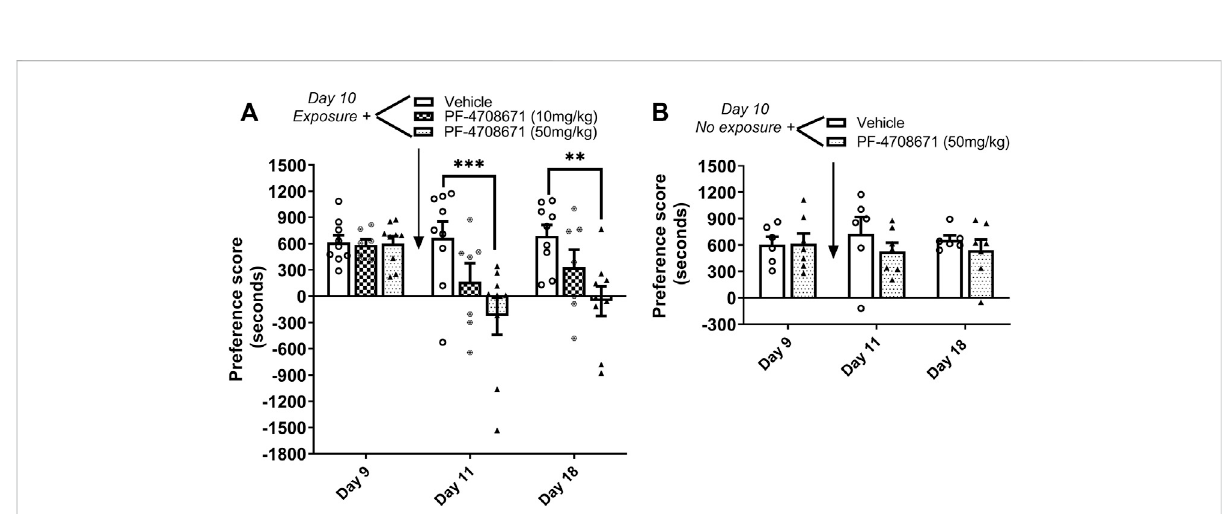
FIGURE 4 Inhibition of p70S6K attenuates reconsolidation of cocaine contextual memory. (A) Condition place preference was established with cocaine 10 mg/kg in three groups of mice as shown on day 9 during a 30-min test session. Mice were re-exposed to the cocaine-paired context in a drug- free state for 10 min to reactivate cocaine-associated memories on day 10. The p70S6K inhibitor, PF-4708671 (10 or 50 mg/kg ip), or vehicle was administeredimmediatelyafterexposuretothecocainecompartment.Micewerere-testedforcocaineplacepreference24 hand7 dlater.PF- 4708671 (50 mg/kg) signi fi cantly abolished the previously established place preference when tested 24 h and 7 d after administration (days 11 and 18). Mice injected with vehicle maintained a signi fi cant cocaine place preference on days 11 and 18. (B) Condition place preference was established with cocaine 10 mg/kg in two groups of mice as shown on day 9. On day 10, mice remained in their home cages in the testing room and were injected with PF-4708671 (50 mg/kg ip) or vehicle. The test for cocaine place preference was repeated 24 h and 7 days later. PF-4708671 administered in the home cage (i.e., no exposure to the cocaine context) did not alter the previously established cocaine place preference; both vehicle and PF-4708671 groups maintained a cocaine place preference when retested on days 11 and 18 in the absence of re-exposure to the cocaine context. ** p < 0.01, *** p < 0.001 for drug vs. vehicle at same time point; Data are expressed as means ± SEM. N = 9 –